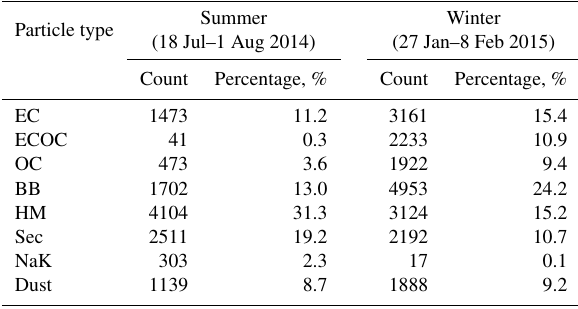
Table 1. Summary of major groups of oxalic-acid-containing parti- cles in summer and winter in PRD,